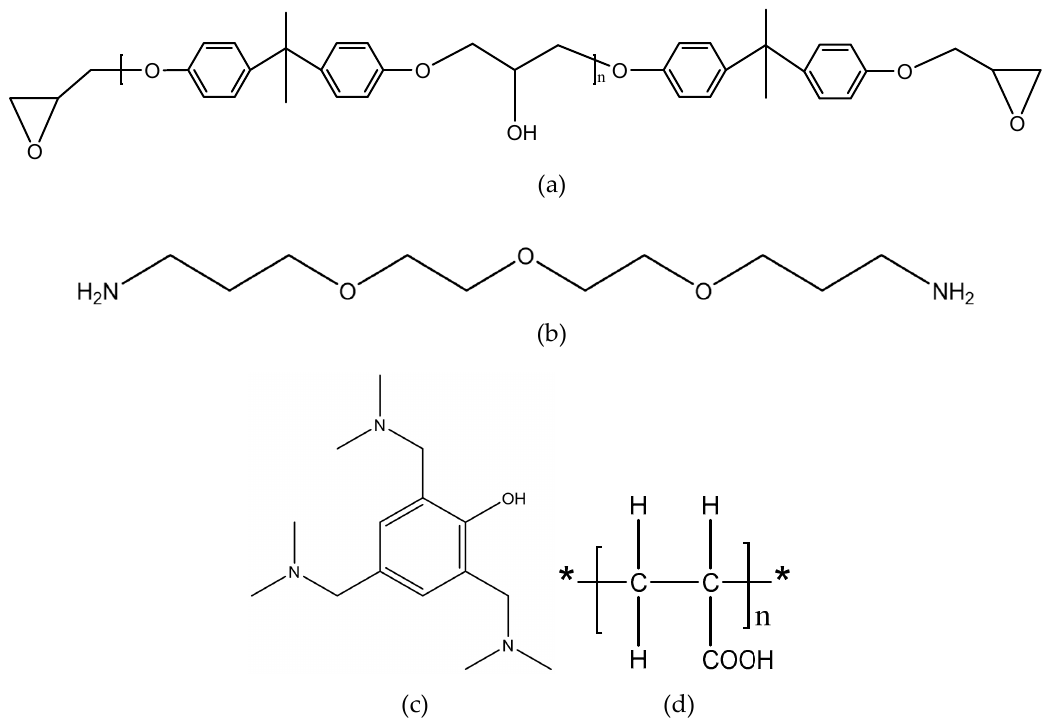
Figure 1. Structural formulas of ( a ) bisphenol A epoxy resin, ( b ) diethylene glycol bis (3-aminopropyl) ether, ( c ) 2,4,6-tris (dimethylaminomethyl) phenol, and ( d ) polyacrylic acid.